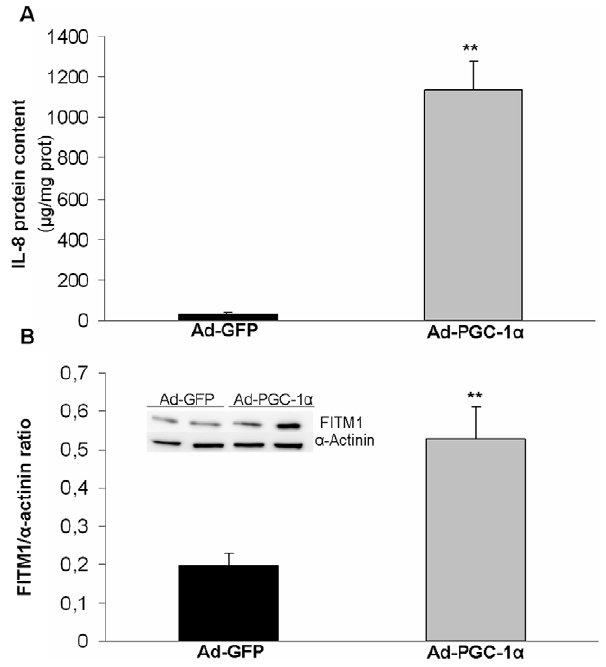
Figure 3. Upregulation of IL-8 and FITM1 protein content by PGC-1 a -overexpression in cultured skm cells. Cultured skm cells were transduced with Ad-GFP or Ad-PGC-1 a . In cell extracts, (A) ELISA assay for IL-8 and (B) immunoblot analysis of FITM1 were performed. (B) For FITM1, a -actinin was used as loading control; a representative image is shown and bands were quantified. (A and B) Data are means 6 SEM from three experiments performed in triplicate. Significance of differences versus cells treated with Ad-GFP: *p , 0.05.